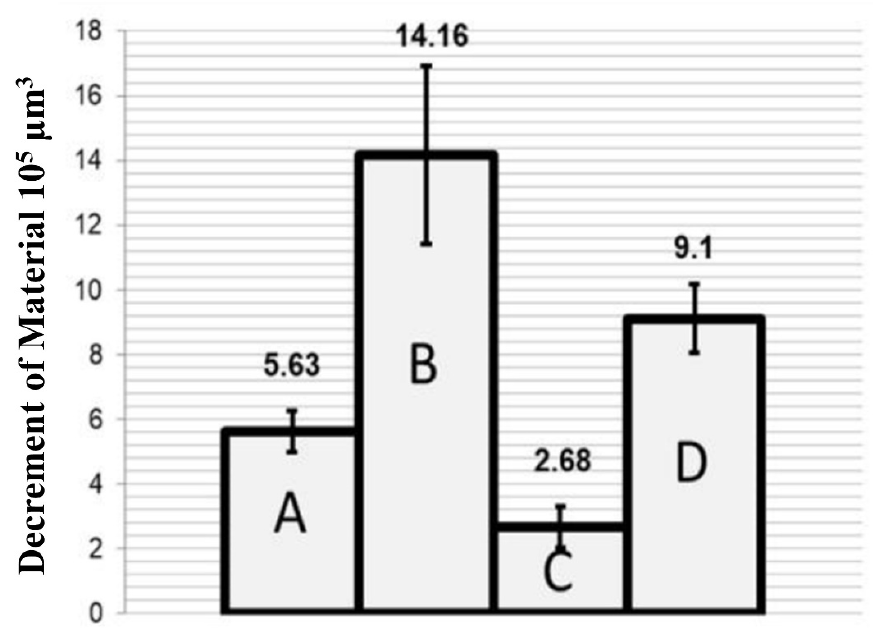
Figure 11. Material loss in (A) Zn coating at 1 N load, (B) Zn coating at 2 N load, (C) Zn/NP nano- composite coating at 1 N load and (D) Zn/NP nanocomposite coating at 2 N load